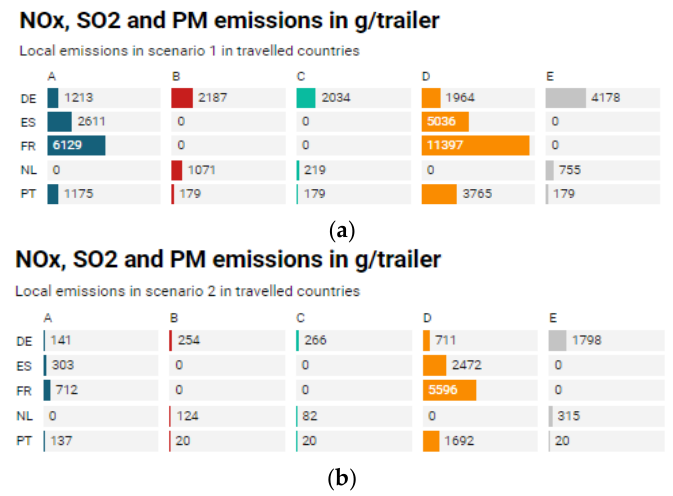
( b ) Figure 5. Share of NO x , SO 2 , and PM emissions per transport mode: ( a ) scenario 1; ( b ) scenario 2. The results of this numerical model may also be extracted per country, as that is an